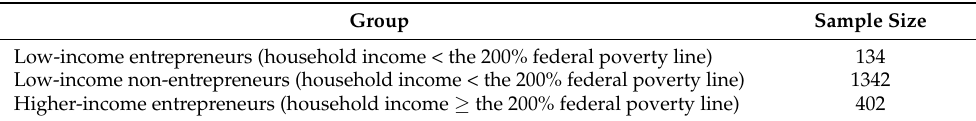
Table 1. Three groups in the analytic sample (N = 1878). Group Sample